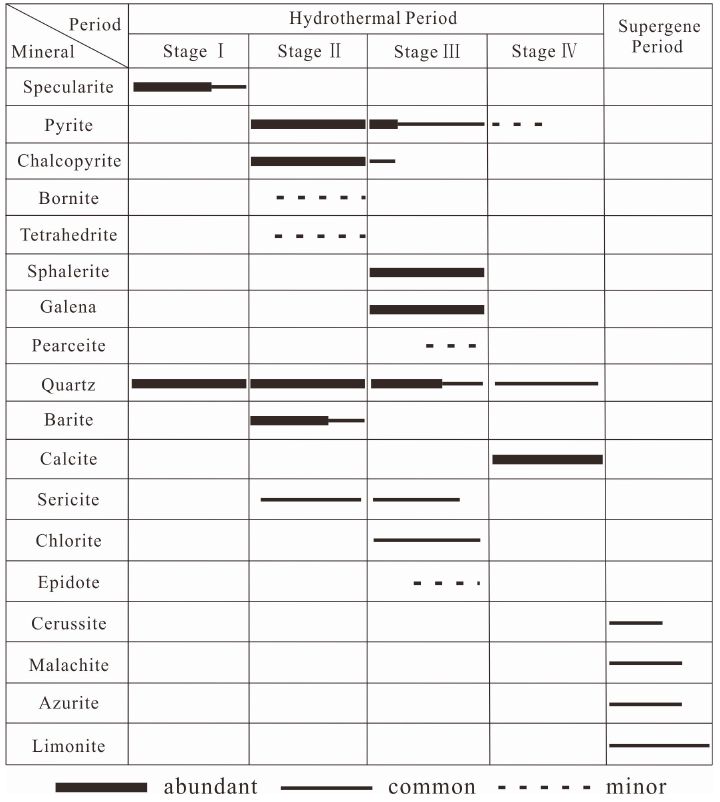
Figure 5. Mineral paragenesis for the Chuduoqu Pb-Zn-Cu deposit.